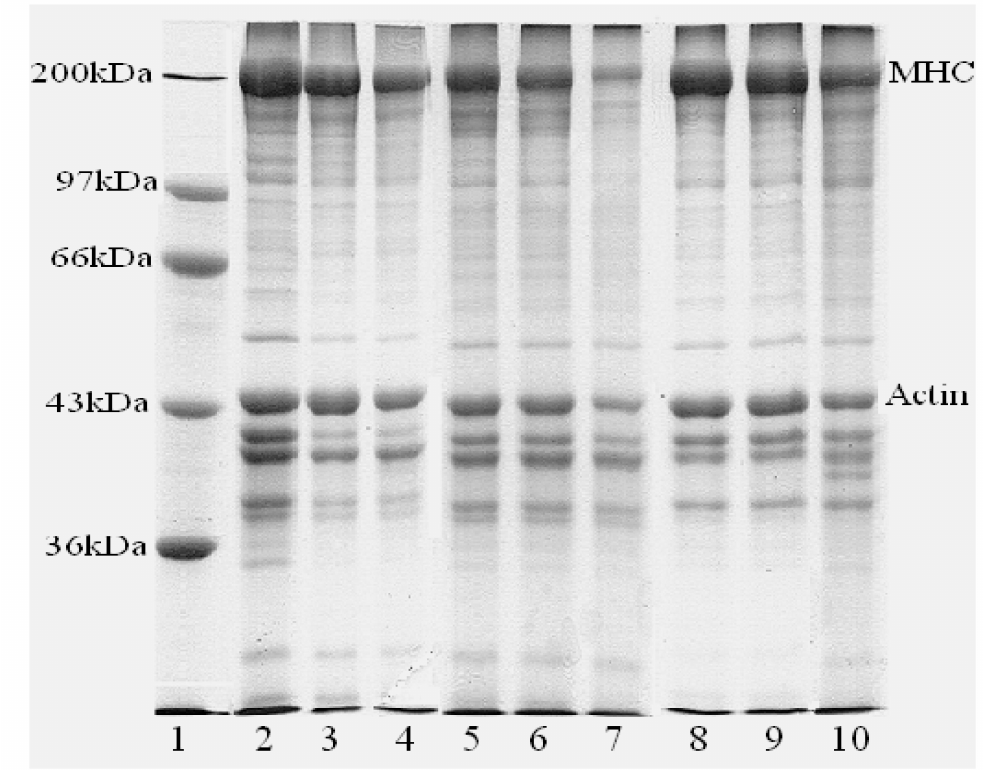
Figure 2. Protein patterns of gels prepared under different conditions: 1, standard proteins; 2, kam- aboko gel of WM; 3, setting gel of WM; 4, modori gel of WM; 5, kamaboko gel of AC; 6, setting gel of AC; 7, modori gel of AC; 8, kamaboko gel of AK; 9, setting gel of AK; and 10, modori gel of AK. WM: water-washed surimi, AC: acid-isolated protein, AK: alkali-isolated